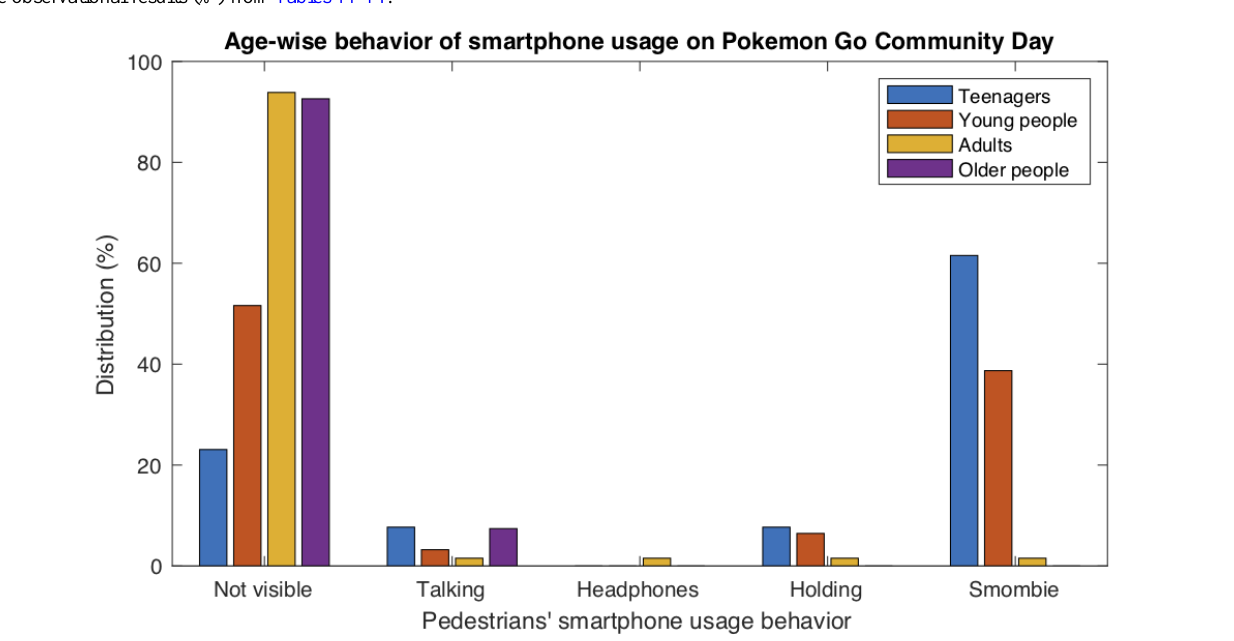
Figure 10. Smartphone usage behavior of pedestrians across different age ranges on the Pokemon Go Community Day. This figure shows graphically the observational results (%) from Tables 11-14.